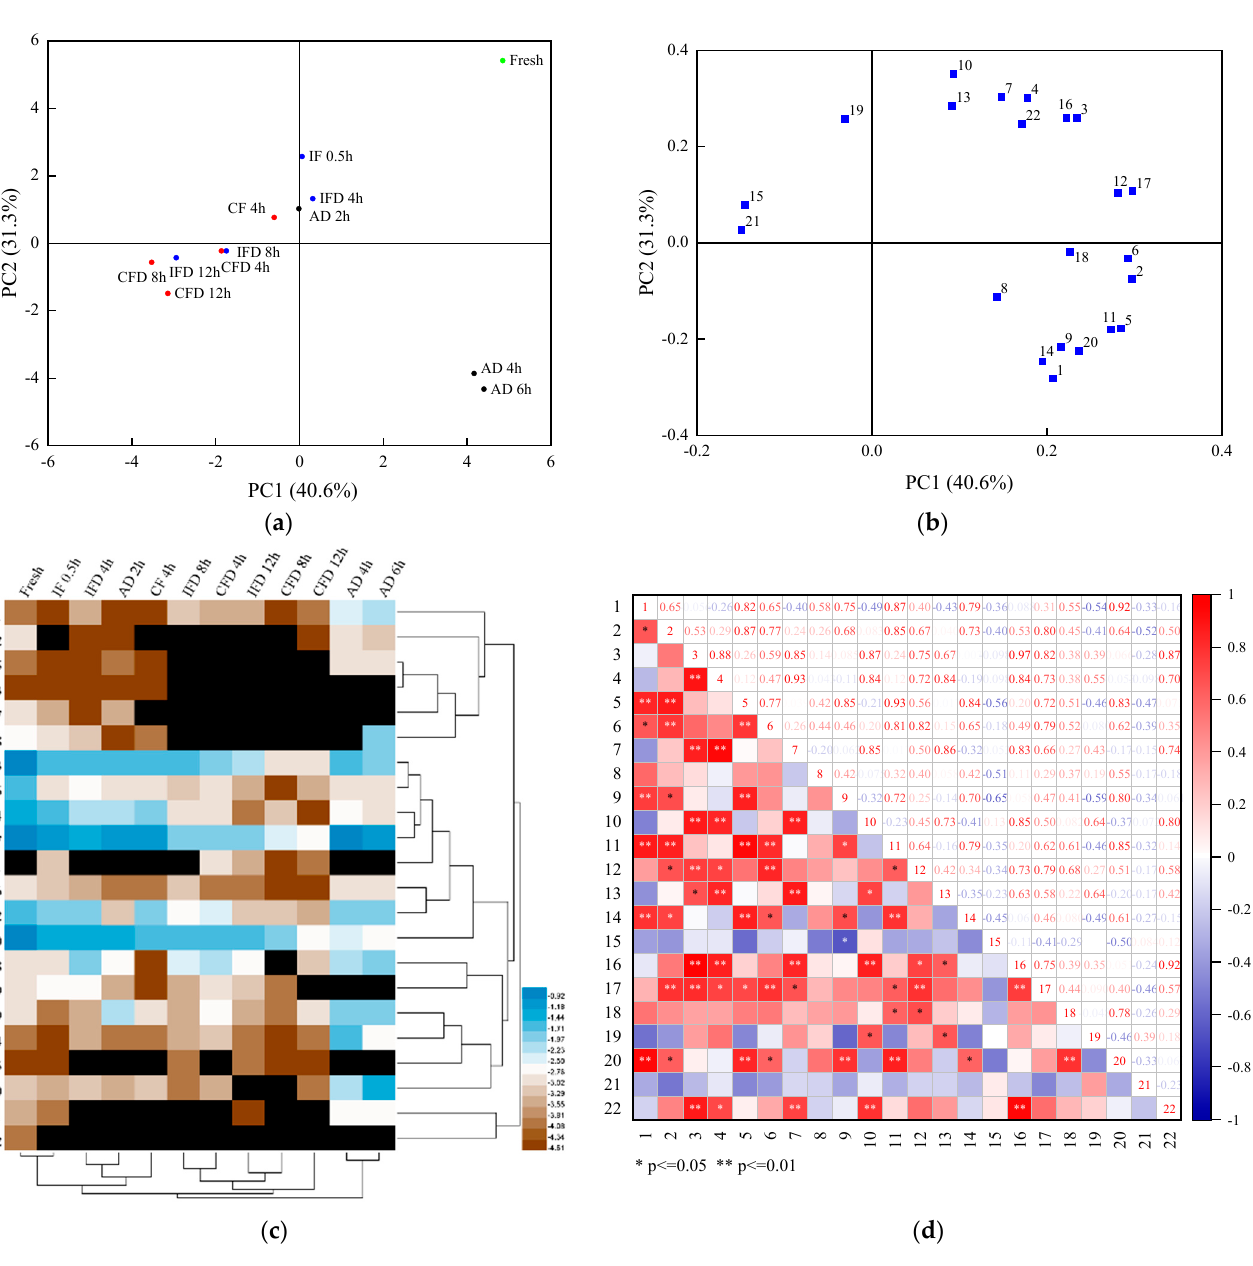
Figure 2. Principal component analysis, hierarchical cluster analysis, and Pearson’s correlation analysis based on the content of volatile flavor compounds in the samples during the drying processes. Numbers 1~22 are the corresponding codes for the 22 kinds of volatile compounds in Table 1. ( a ): Score plot of principal component analysis of the different drying stages; ( b ): Score plot of principal component analysis of the volatile flavor compounds; ( c ): Heatmap of hierarchical cluster analysis; ( d ): Heatmap of Pearson’s correlation analysis.